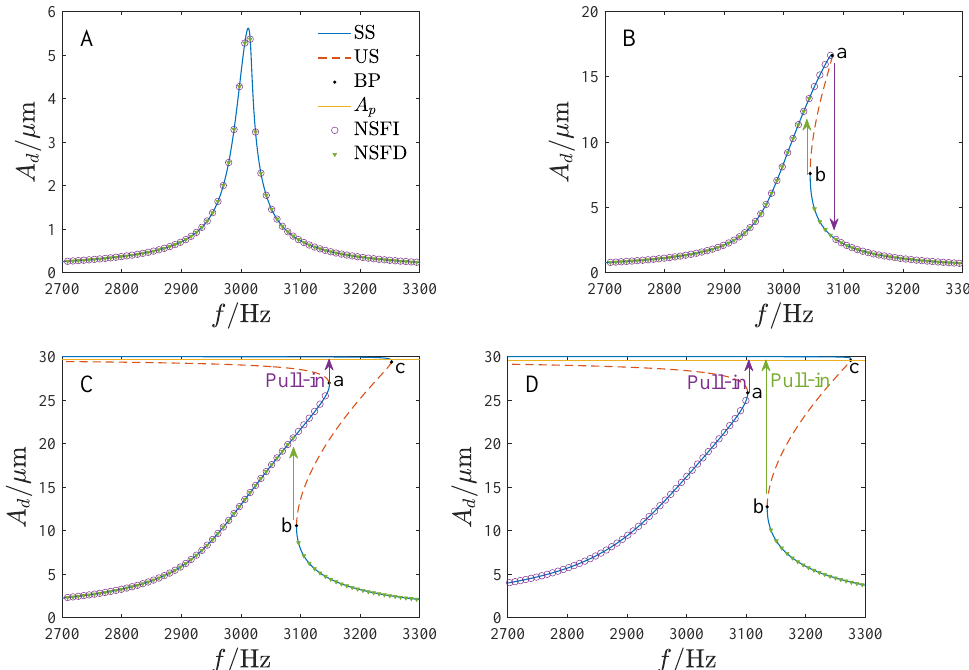
Figure 14. The amplitude–frequency curves in the driving direction correspond to different persistent regions in Figure 12, where SS is the stable solution, US is the unstable solution, BP denotes the bifurcation point, A p is the pull-in boundary amplitude, NSFI is the numerical solution as the frequency is increased, NSFD is the numerical solution as the frequency is decreased; ( A ): V D = V A = 10 V, ( B ): V D = 30 V, V A = 10 V, ( C ): V D = V A = 30 V, ( D ): V D = V A = 40